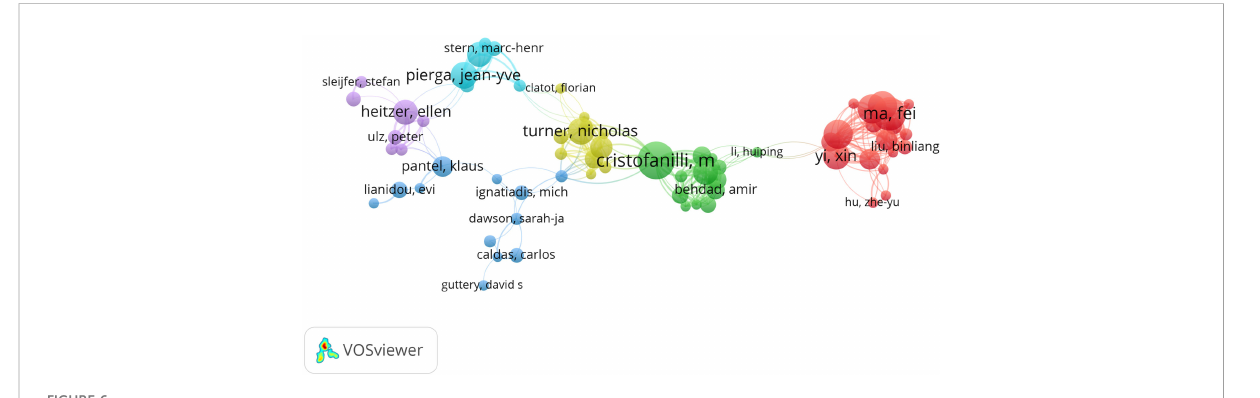
FIGURE 6 Co-authorship analysis between authors in network visualization.